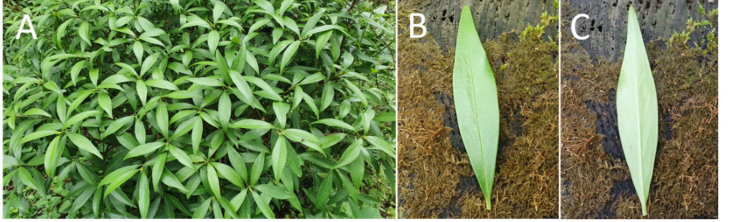
Figure 10. Picture of Daphne jejudoensis plant ( A ) and the front ( B ) and back ( C ) of its